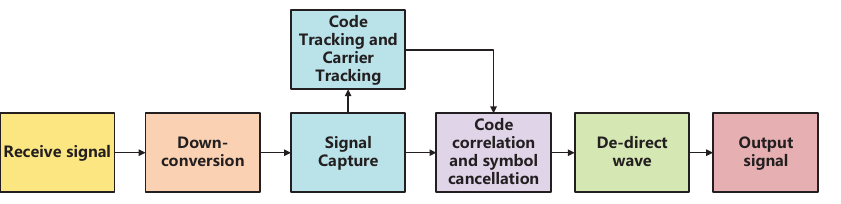
Figure 3. Flow chart of forward scatter signal preprocessing.